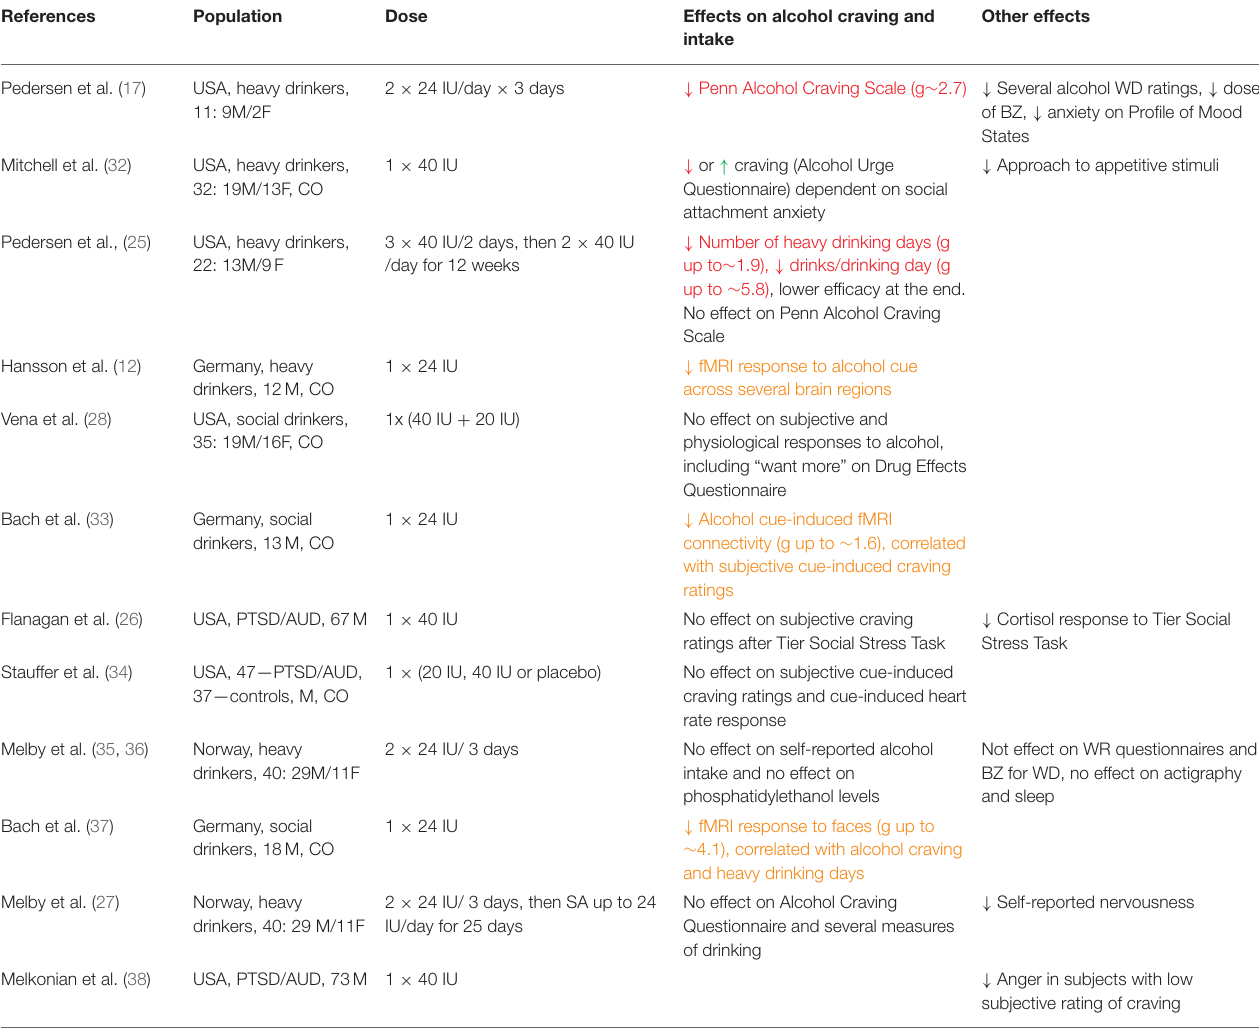
TABLE 1 | Clinical studies on effects of oxytocin administration on alcohol-related